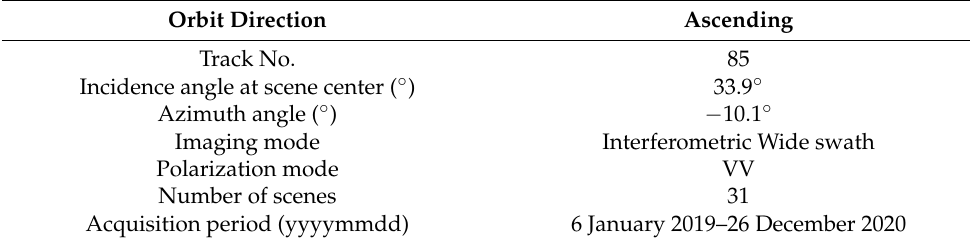
Table 1. Sentinel-1 image parameters.